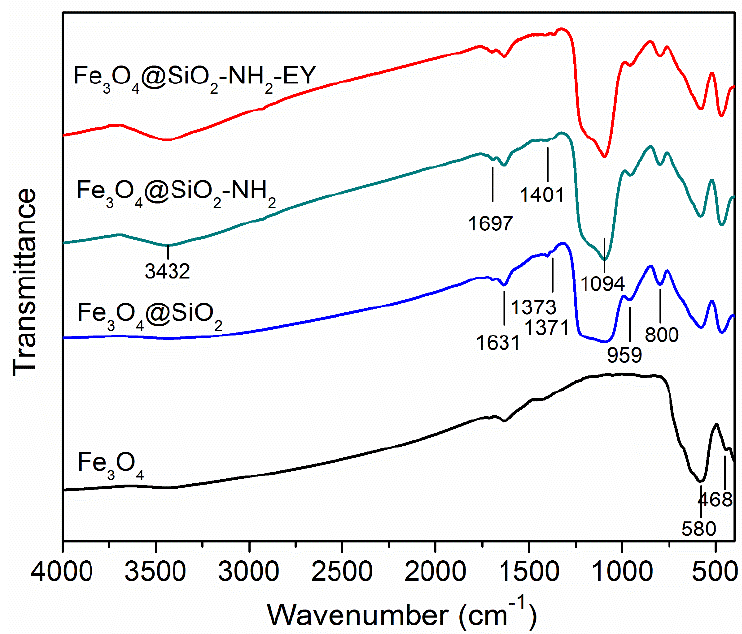
Figure 4. FT-IR spectra for Fe 3 O 4 , Fe 3 O 4 @SiO 2 , Fe 3 O 4 @SiO 2 -NH 2 , and Fe 3 O 4 @SiO 2 -NH 2 -EY.